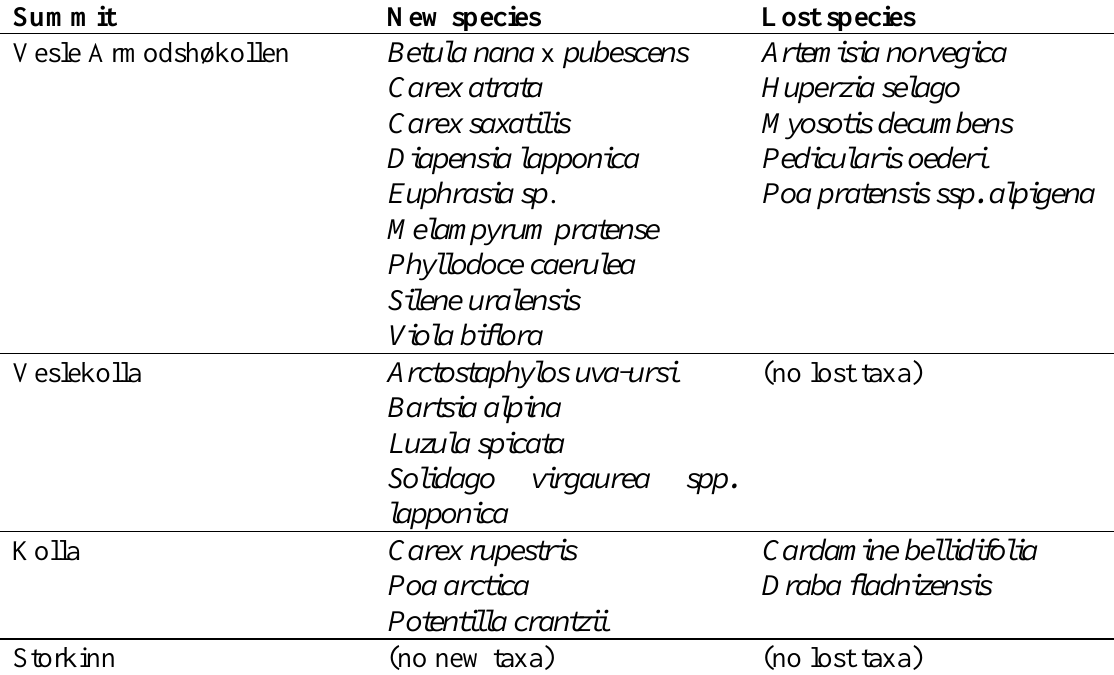
Table 2. New and lost taxa at the summits from 2001 to